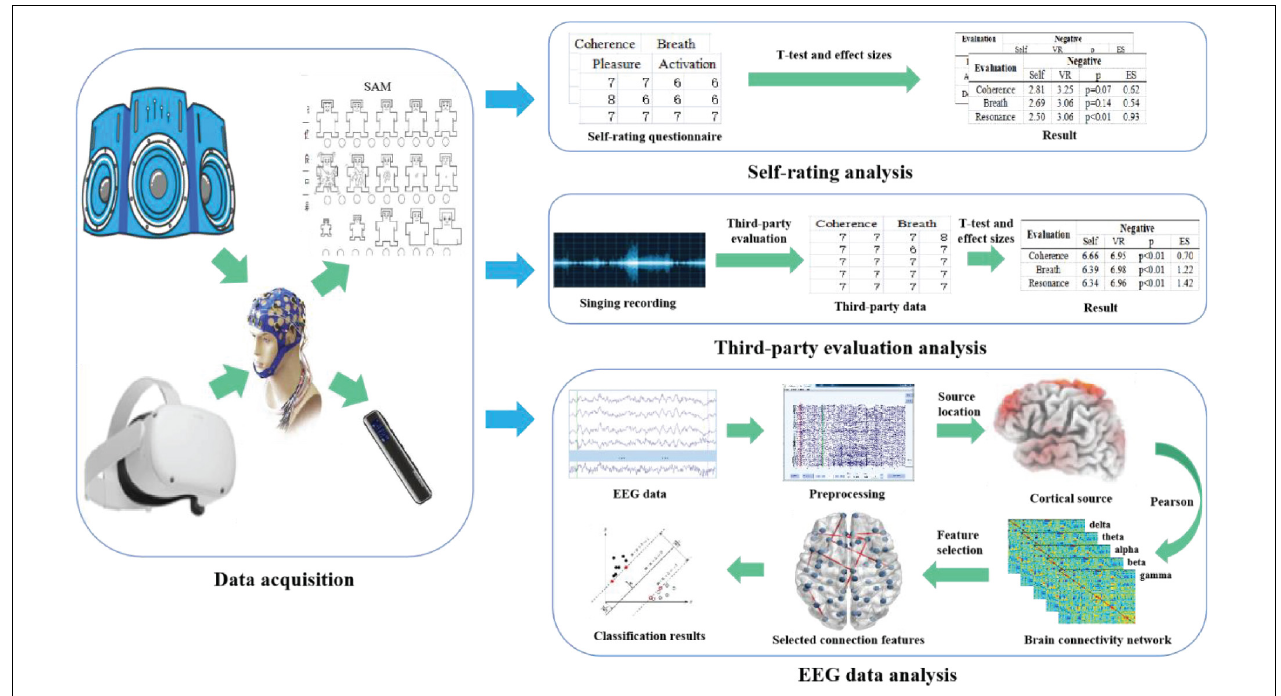
FIGURE 1 | The flow chart of the empirical study.